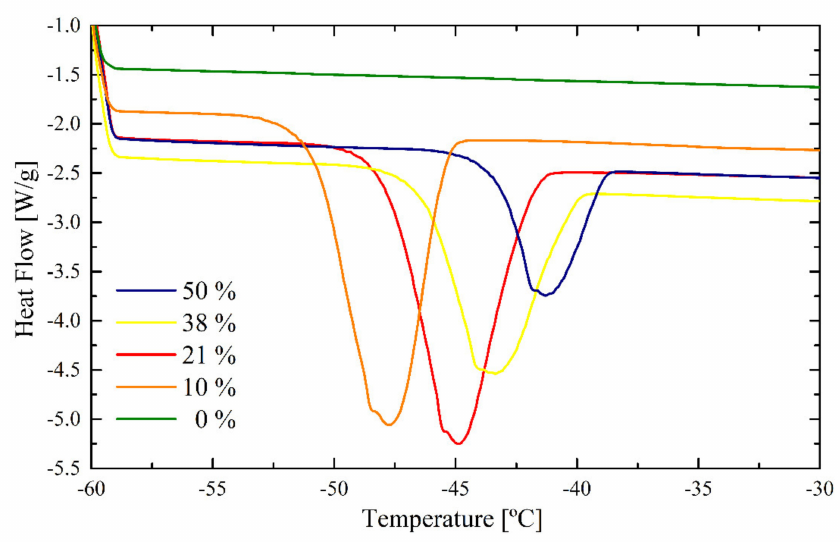
Figure 9. DSC peaks for bound freezing of the REF